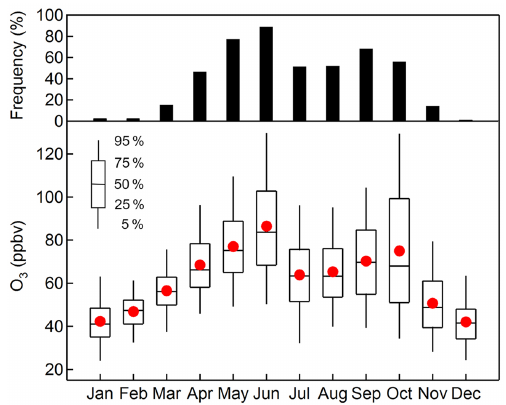
Figure 2. Seasonal variation of surface O 3 mixing ratios at Mt. Tai derived from the continuous observations from 2006 to 2009. Red dots indicate the monthly average O 3 concentrations. Shown in the upper panel is the frequency of the MDA8 O 3 exceeding the Chi- nese national ambient air quality standard, i.e. 75ppbv (Class